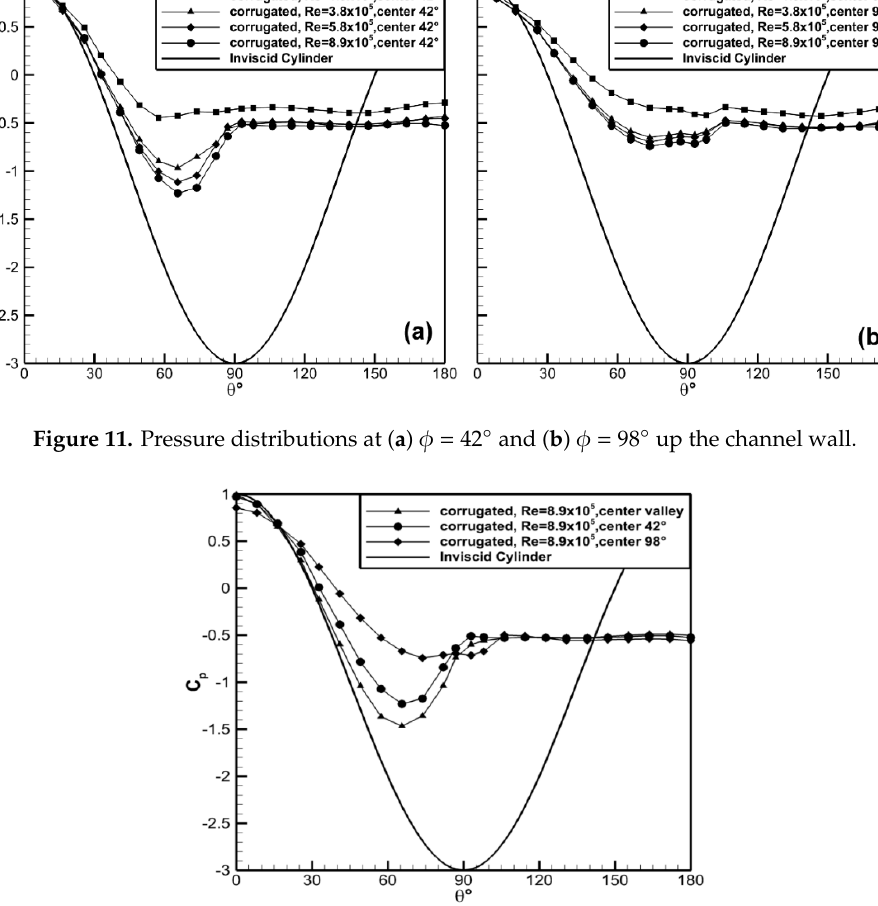
Figure 13. Comparison of pressure distribution in the center and top channels. ( a ) Re = 1.9 × 10 5 , ( b ) Re = 7.7 × 10 5 .